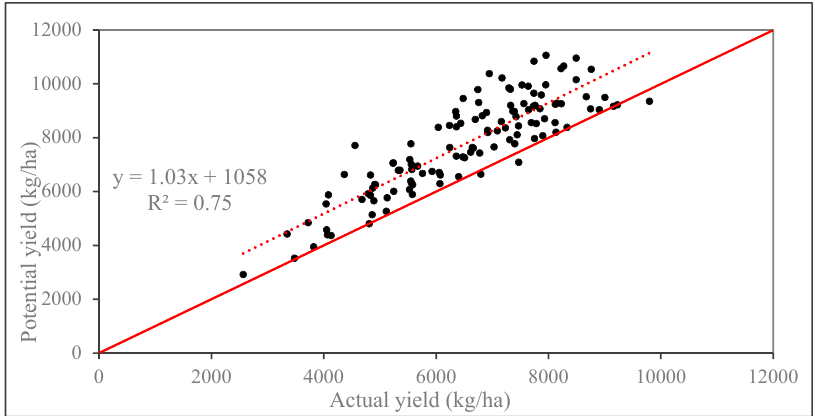
Figure 3. Correlation between maize potential and actual yields of each city in Northeast China from 1990 to 2015.